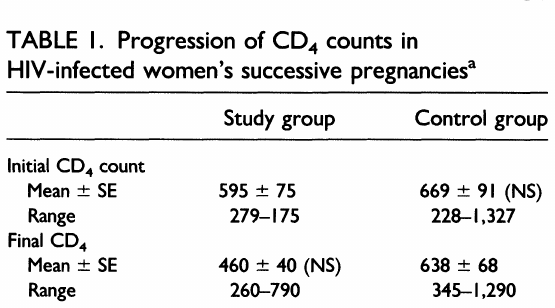
TABLE I. Progression of CO